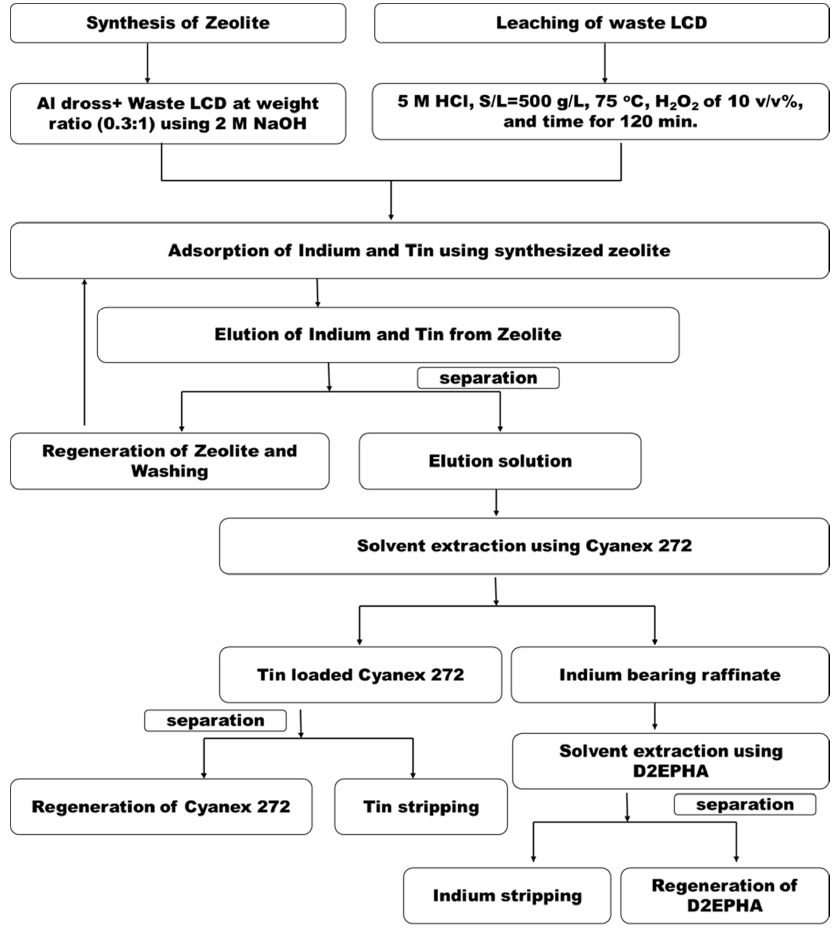
Figure 6. Potential application flowsheet where indium can be recovered from leach liquor of waste LCD through leaching using Zeolite.